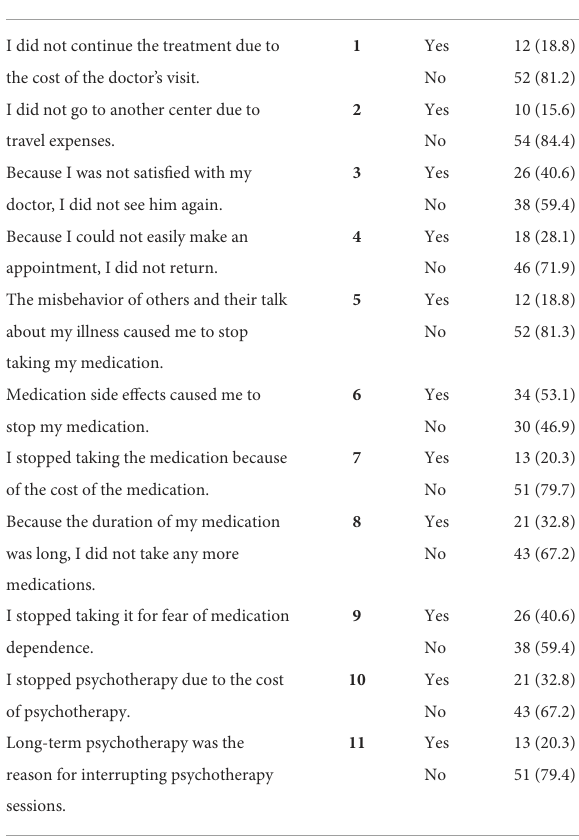
TABLE 1 Demographic and clinical characteristics of participants.